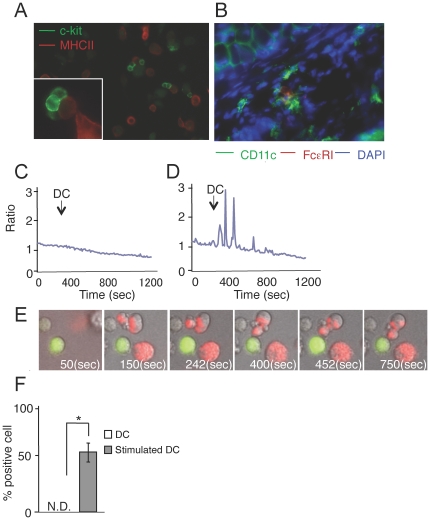
Stimulated BMDCs enhance Ca2+ influx in BMMCs and BMMCs interact with DCs in vitro and in vivo.(A) On poly-L-lysine coated glass coverslips, c-kit+ BMMCs (green) contacted MHC class II+ BMDCs (red). (B) Conjugate formation of CD11c+ DCs (green) with FcεRIα+ MCs (red) in the sensitized skin. (C–E) BMMCs (green) were co-cultured with non-stimulated BMDCs (C) or BMDCs stimulated with 100 ng/ml of LPS and 50 ng/ml of CCL21 for 1 h (red; D, E), and the intracellular Ca2+ was monitored by Fluo-8 for 1200 sec. Photos were taken at the indicated time points from Supplemental Movie 2 (E). (F) The percentage of BMMCs demonstrating high Ca2+ concentration among BMMCs. Data are presented as the mean ± SD and are representative of three experiments. *, P<0.05 versus a corresponding group.